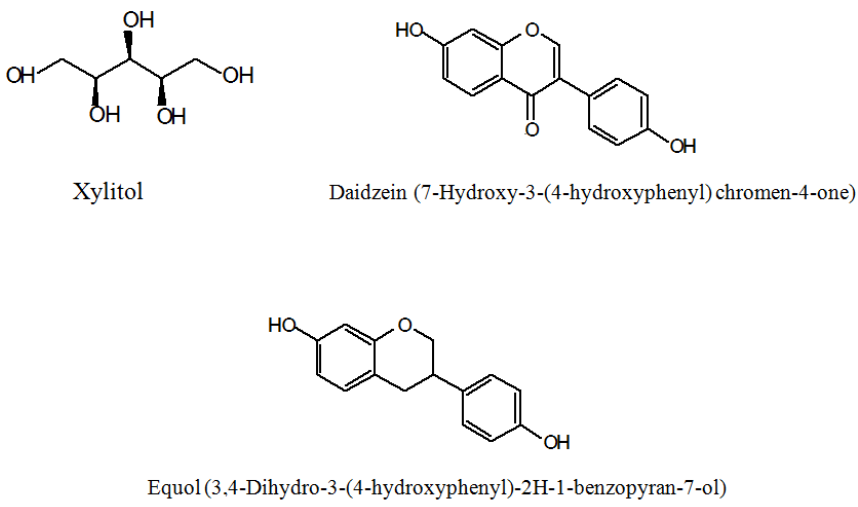
Figure 1. Chemical structure of xylitol, daidzein and